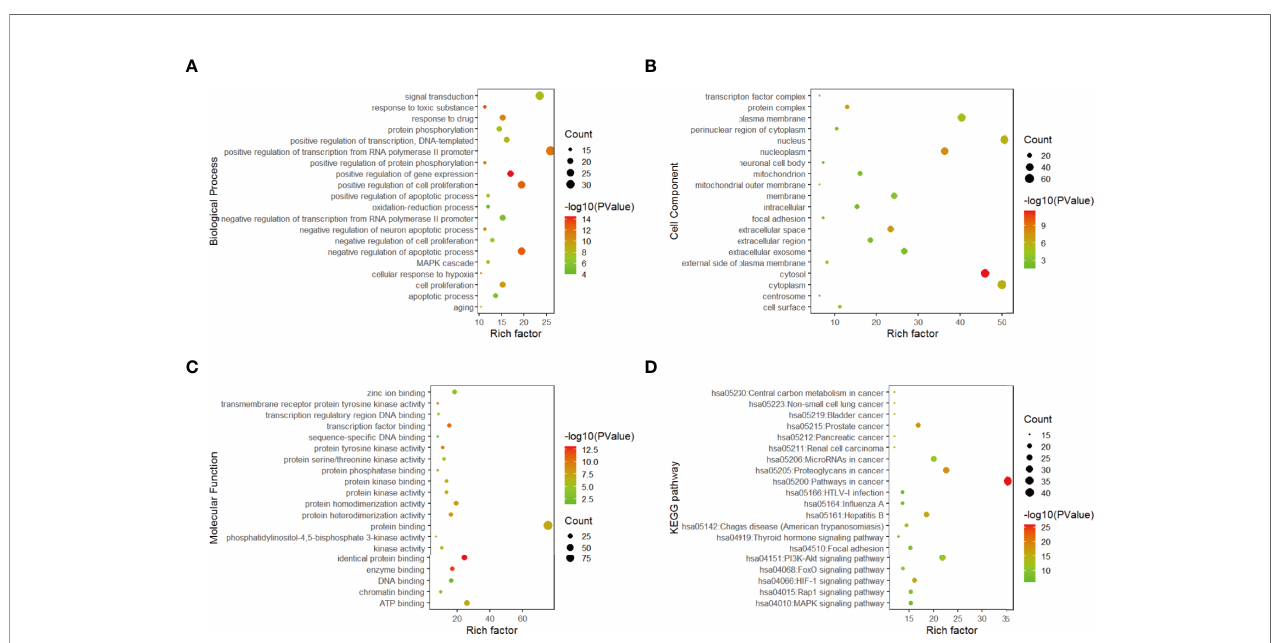
FIGURE 3 | Gene enrichment analysis. (A) Top 20 biological process diagram of targets of 11 traditional Chinese medicines. (B) Top 20 cell composition diagrame of targets of 11 traditional Chinese medicines. (C) Top20 molecular function diagram of (D) enrichment analysis of top 20 KEGG